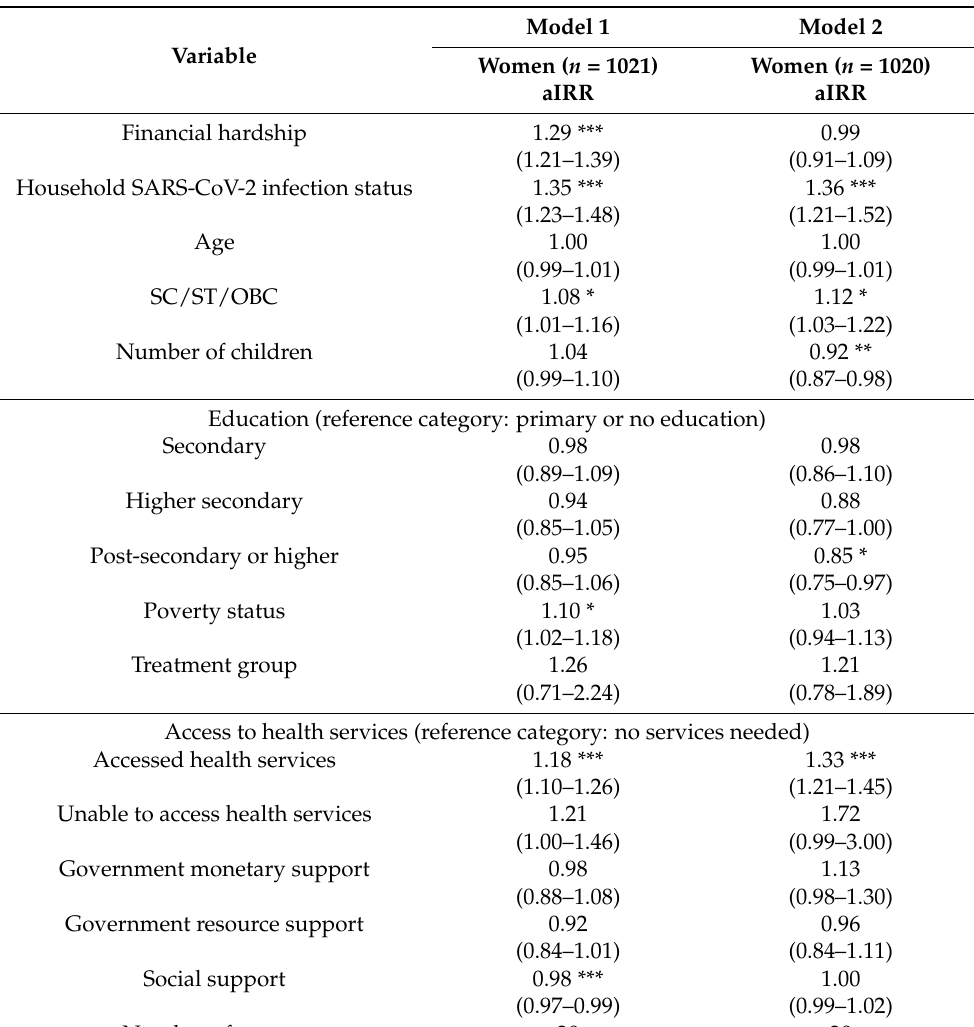
Table 3. Multivariate associations between financial hardship and mental health symptoms by